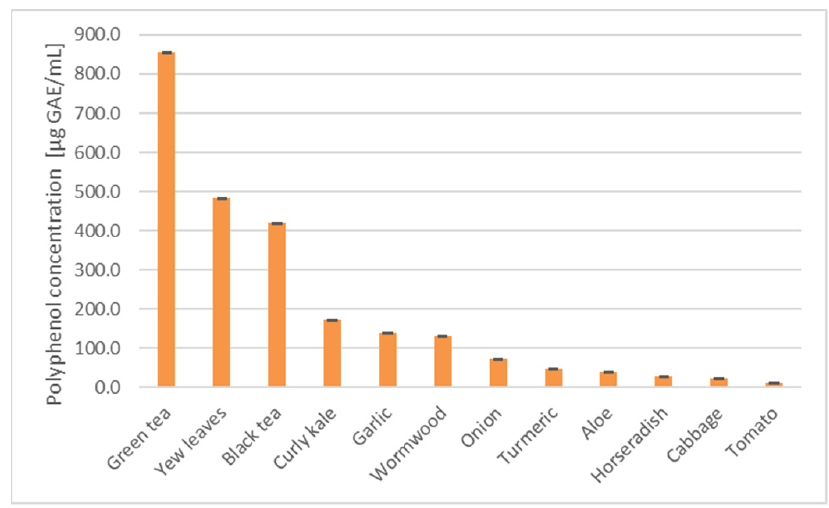
Figure 3. Polyphenol concentration in the extracts and infusions.